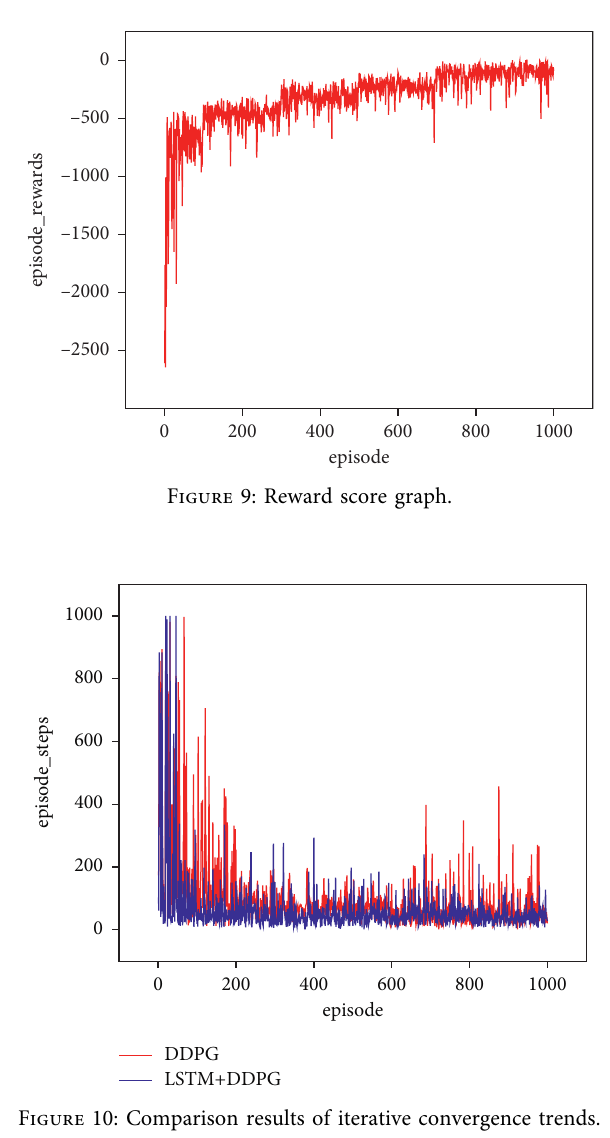
Figure 10: Comparison results of iterative convergence trends.